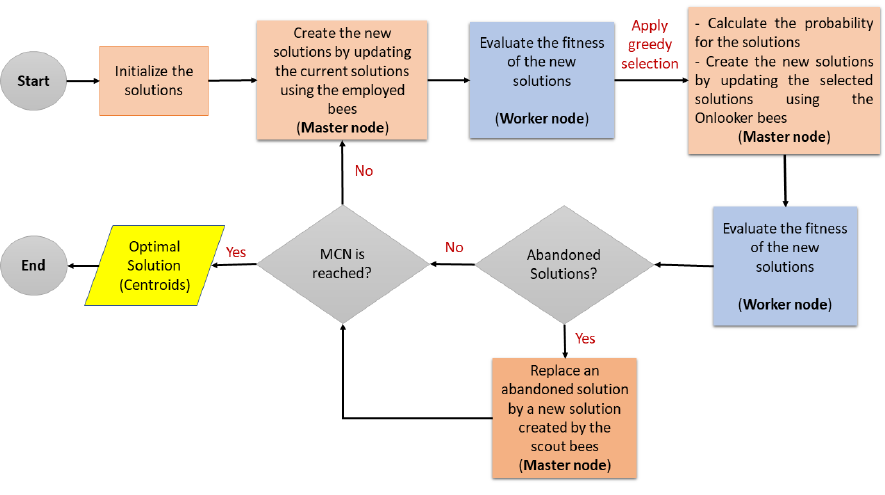
Figure 1. Adopting Spark-based ABCC for big data classification.